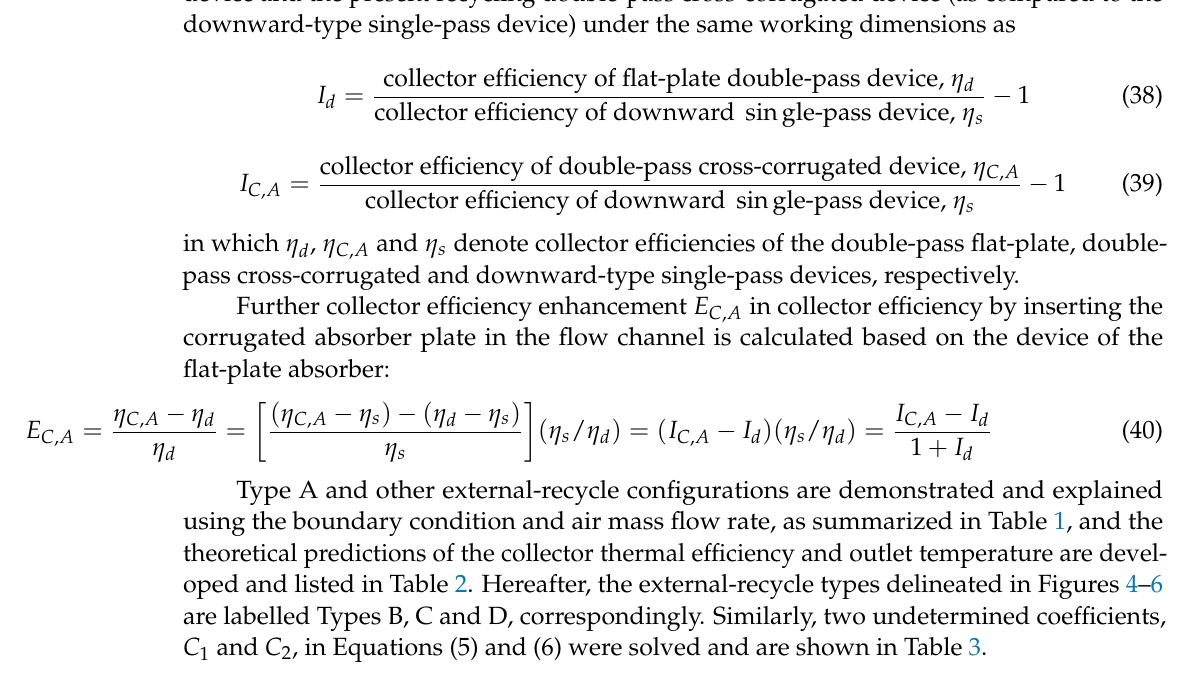
Table 1. Air mass flow rates and boundary conditions for Type A–D.